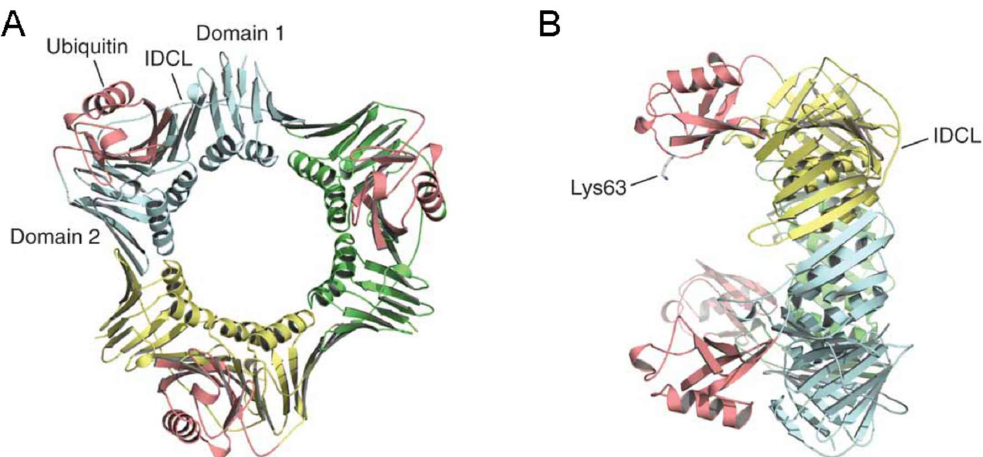
Figure 4. Structure of a monoubiquitinated PCNA ring (picture from reference [22]). ( A ) Back view of monoubiquitinated PCNA ring showing the two domains of a single PCNA subunit and the inter-domain connecting loop (IDCL). Ubiquitin is shown in red. Three individual PCNA molecules (shown in blue, green, and yellow) constitute the ring shape; ( B ) Side view of the monoubiquitinated PCNA where the back surface is to the left and the front surface is to the right of the figure. Notice that the ubiquitin is located on the back surface of the PCNA ring while IDCL is to the front side of the PCNA ring.